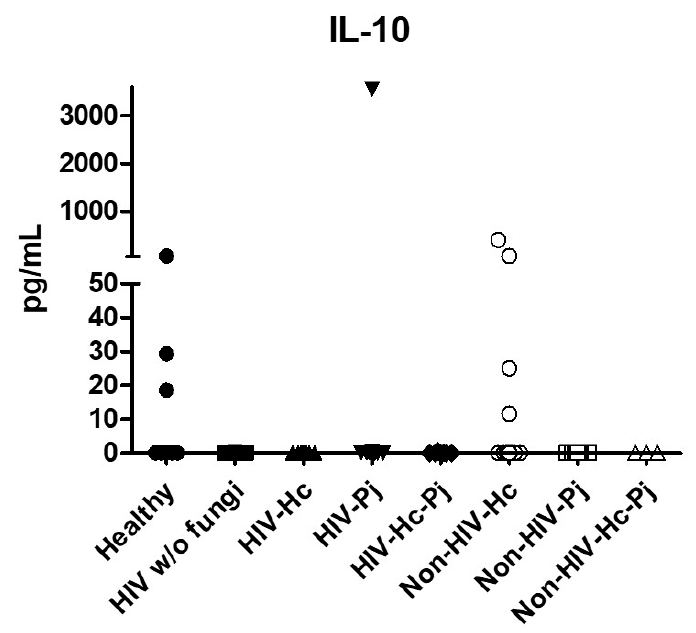
Figure 6. Determination of cytokines associated with granuloma formation. IL-33, IL-5, and IL-13 were detected by a cytometric bead assay in the BAL samples of hospitalized patients; results were obtained in pg/mL. Median values are shown for ( A ) IL-33, ( B ) IL-5, and ( C ) IL-13. * p < 0.05.